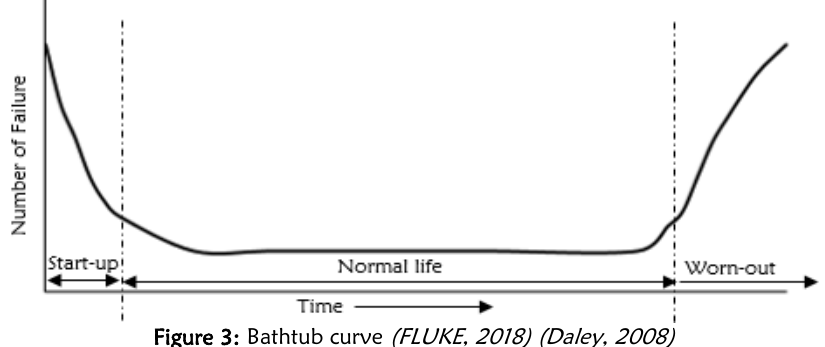
Figure 3: Bathtub curve (FLUKE, 2018) (Daley, 2008)